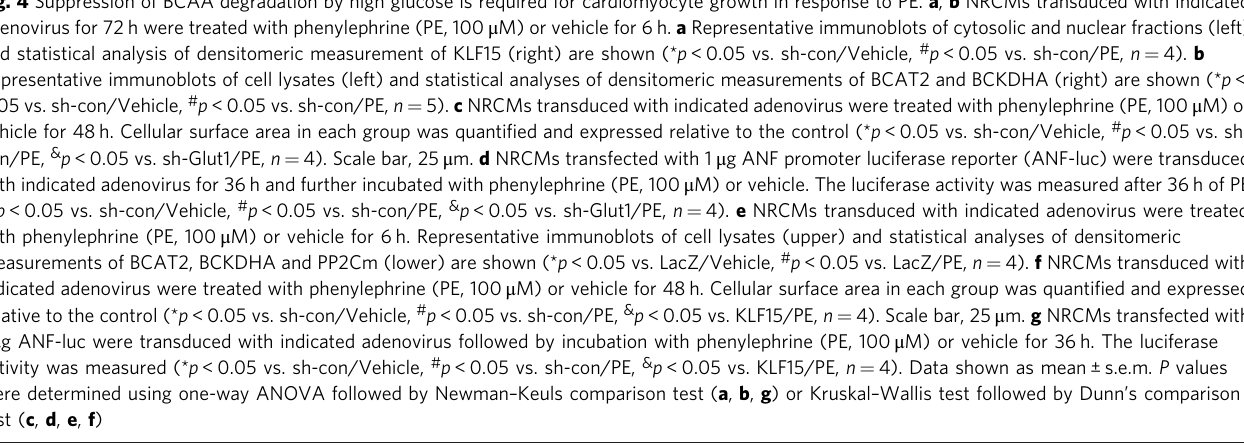
Fig. 4 Suppression of BCAA degradation by high glucose is required for cardiomyocyte growth in response to PE. a , b NRCMs transduced with indicated adenovirus for 72 h were treated with phenylephrine (PE, 100 μ M) or vehicle for 6 h. a Representative immunoblots of cytosolic and nuclear fractions (left) and statistical analysis of densitomeric measurement of KLF15 (right) are shown (* p < 0.05 vs. sh-con/Vehicle, # p < 0.05 vs. sh-con/PE, n = 4). b Representative immunoblots of cell lysates (left) and statistical analyses of densitomeric measurements of BCAT2 and BCKDHA (right) are shown (* p < 0.05 vs. sh-con/Vehicle, # p < 0.05 vs. sh-con/PE, n = 5). c NRCMs transduced with indicated adenovirus were treated with phenylephrine (PE, 100 μ M) or vehicle for 48 h. Cellular surface area in each group was quanti fi ed and expressed relative to the control (* p < 0.05 vs. sh-con/Vehicle, # p < 0.05 vs. sh- con/PE, & p < 0.05 vs. sh-Glut1/PE, n = 4). Scale bar, 25 μ m. d NRCMs transfected with 1 μ g ANF promoter luciferase reporter (ANF-luc) were transduced with indicated adenovirus for 36 h and further incubated with phenylephrine (PE, 100 μ M) or vehicle. The luciferase activity was measured after 36 h of PE (* p < 0.05 vs. sh-con/Vehicle, # p < 0.05 vs. sh-con/PE, & p < 0.05 vs. sh-Glut1/PE, n = 4). e NRCMs transduced with indicated adenovirus were treated with phenylephrine (PE, 100 μ M) or vehicle for 6 h. Representative immunoblots of cell lysates (upper) and statistical analyses of densitomeric measurements of BCAT2, BCKDHA and PP2Cm (lower) are shown (* p < 0.05 vs. LacZ/Vehicle, # p < 0.05 vs. LacZ/PE, n = 4). f NRCMs transduced with indicated adenovirus were treated with phenylephrine (PE, 100 μ M) or vehicle for 48 h. Cellular surface area in each group was quanti fi ed and expressed relative to the control (* p < 0.05 vs. sh-con/Vehicle, # p < 0.05 vs. sh-con/PE, & p < 0.05 vs. KLF15/PE, n = 4). Scale bar, 25 μ m. g NRCMs transfected